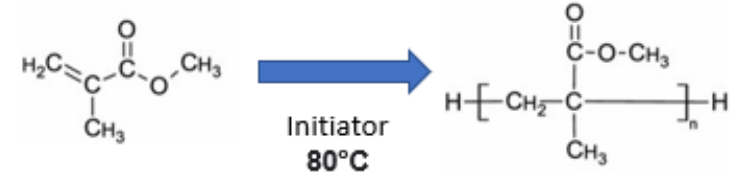
Figure 3. Chemical reaction of heat curing process [7].